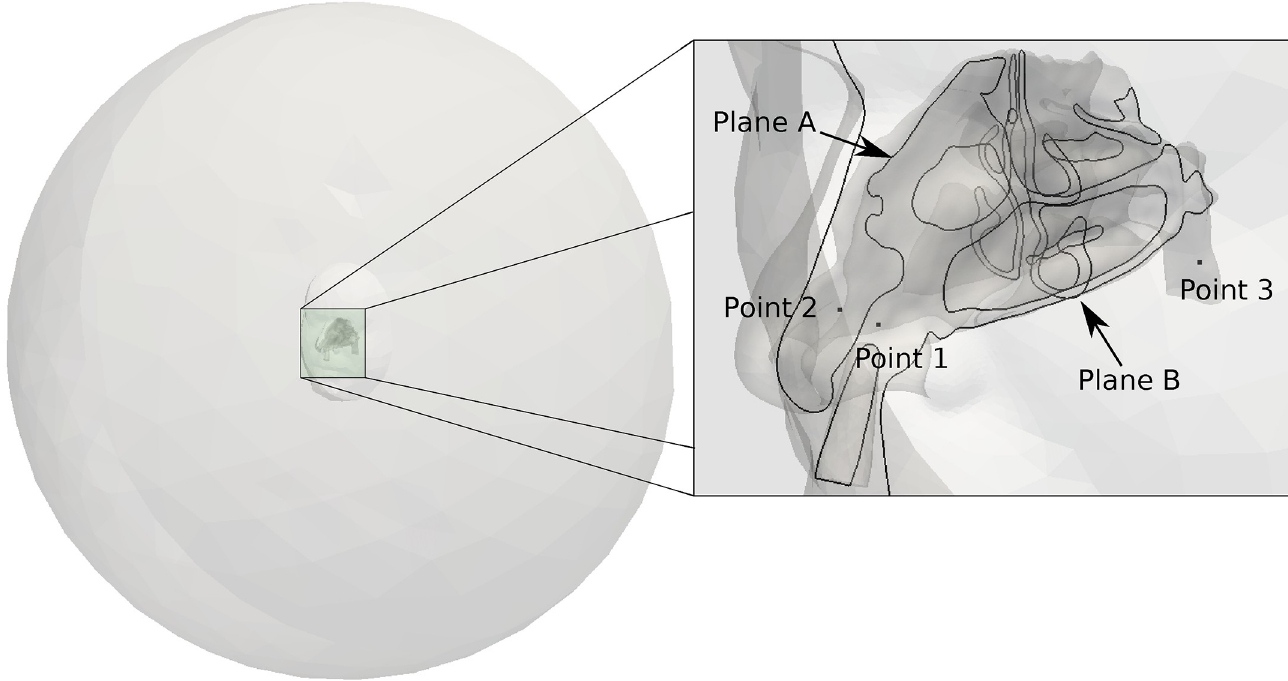
Fig 1. Geometry description details of planes, and points used in this study. Plane A: sagittal section through left nasal cavity; Plane B: coronal section through nasal cavity; Point 1 is located in the left vestibule; Point 2 on the right vestibule; and Point 3 in the posterior nasopharynx.